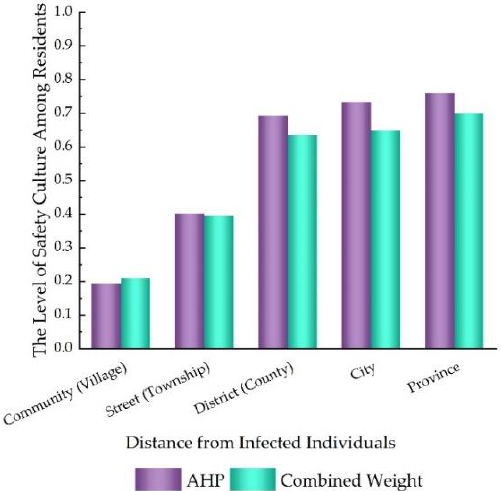
Figure 7. Comparison between different methods.